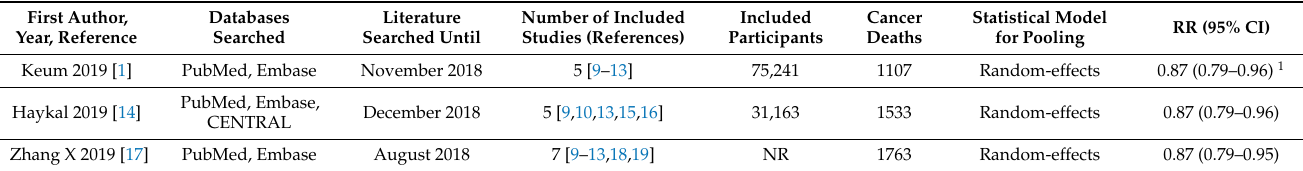
Table 1. Recent meta-analyses of randomized controlled trials on vitamin D supplementation and cancer